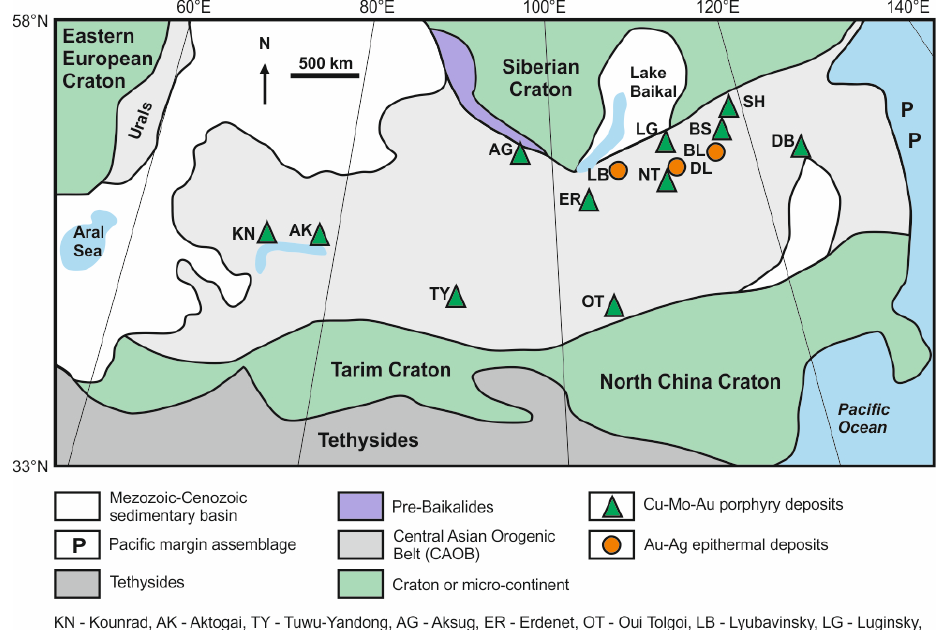
Figure 18. Distribution of major adakite-hosted Cu–Au porphyry (triangles) and A-uAg epithermal (circles) deposits within the Central Asian Orogenic Belt (CAOB). General tectonic setting of the CAOB and surrounding cratons is modified from [246].